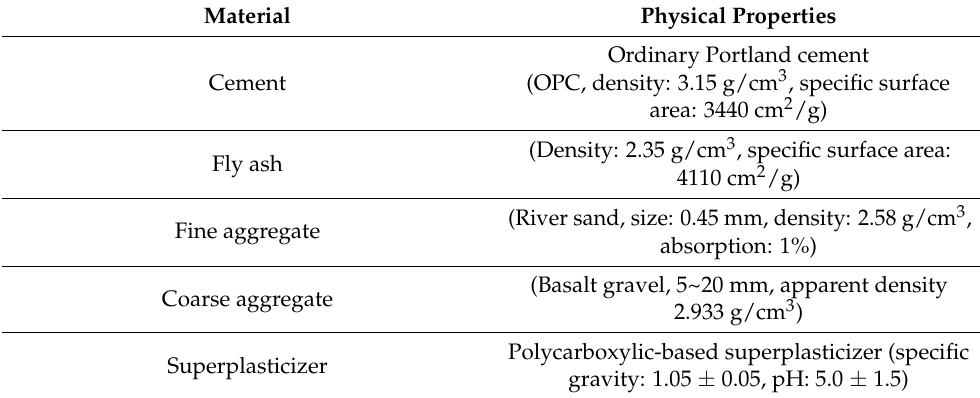
Table 2. Physical–mechanical properties of used material.